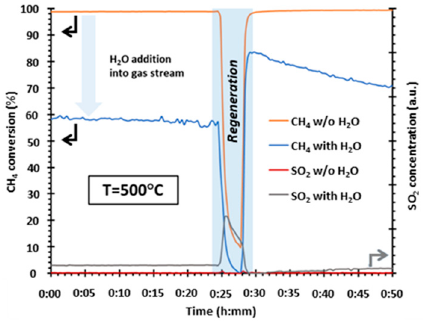
Figure 1. E ff ect of water vapor in the exhaust gas on regeneration of a model PdSO 4 / Al 2 O 3 methane Figure 1. Effect of water vapor in the exhaust gas on regeneration of a model PdSO 4 /Al 2 O 3 methane combustion catalyst. combustion catalyst.